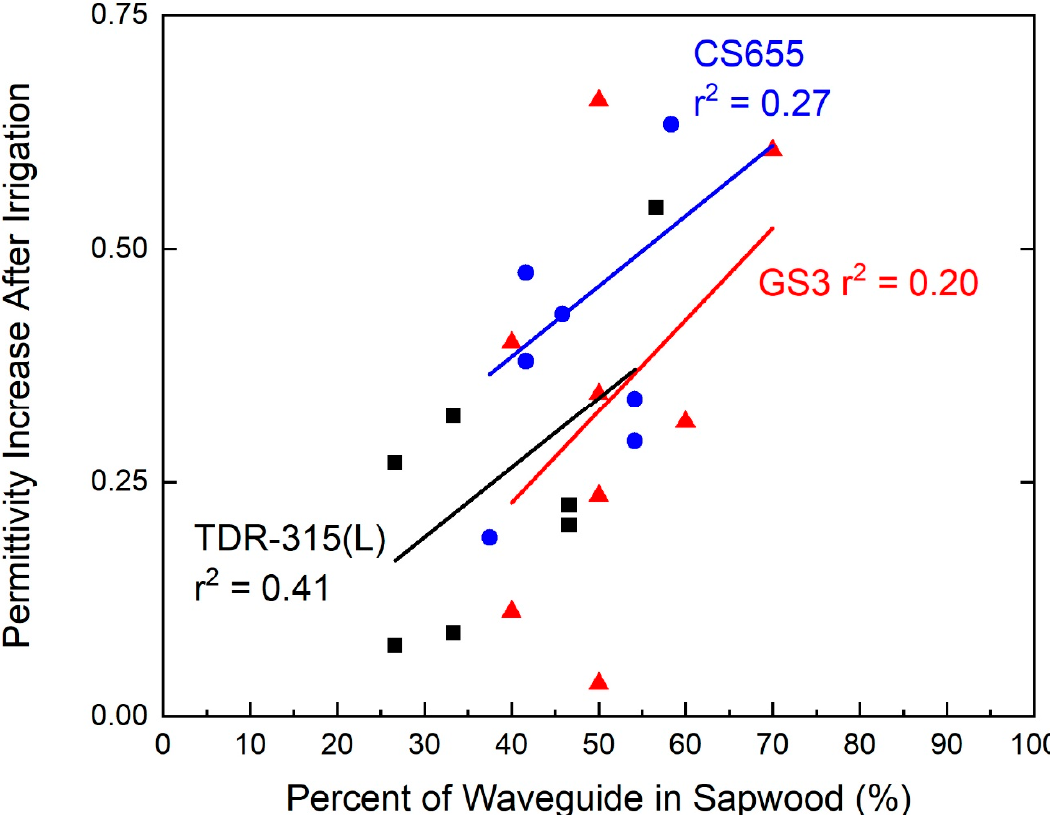
Figure 5. Relationship between waveguide contact with sapwood and changes in permittivity before and after irrigations. Sapwood contact was directly correlated with permittivity increase.